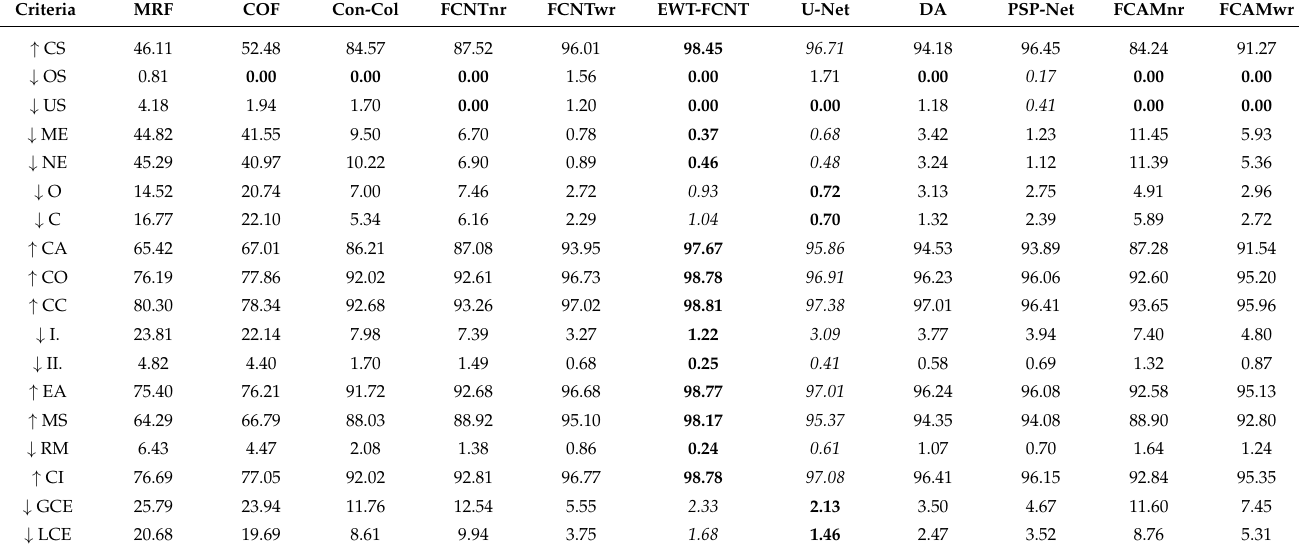
Table 3. Results of supervised methods on the Prague dataset (20 test images). Arrows ↑ , ↓ denote the required criterion direction; “nr” means no segmentation refinement, and “wr” means with segmentation refinement. Best results are in bold, and the second best ones in